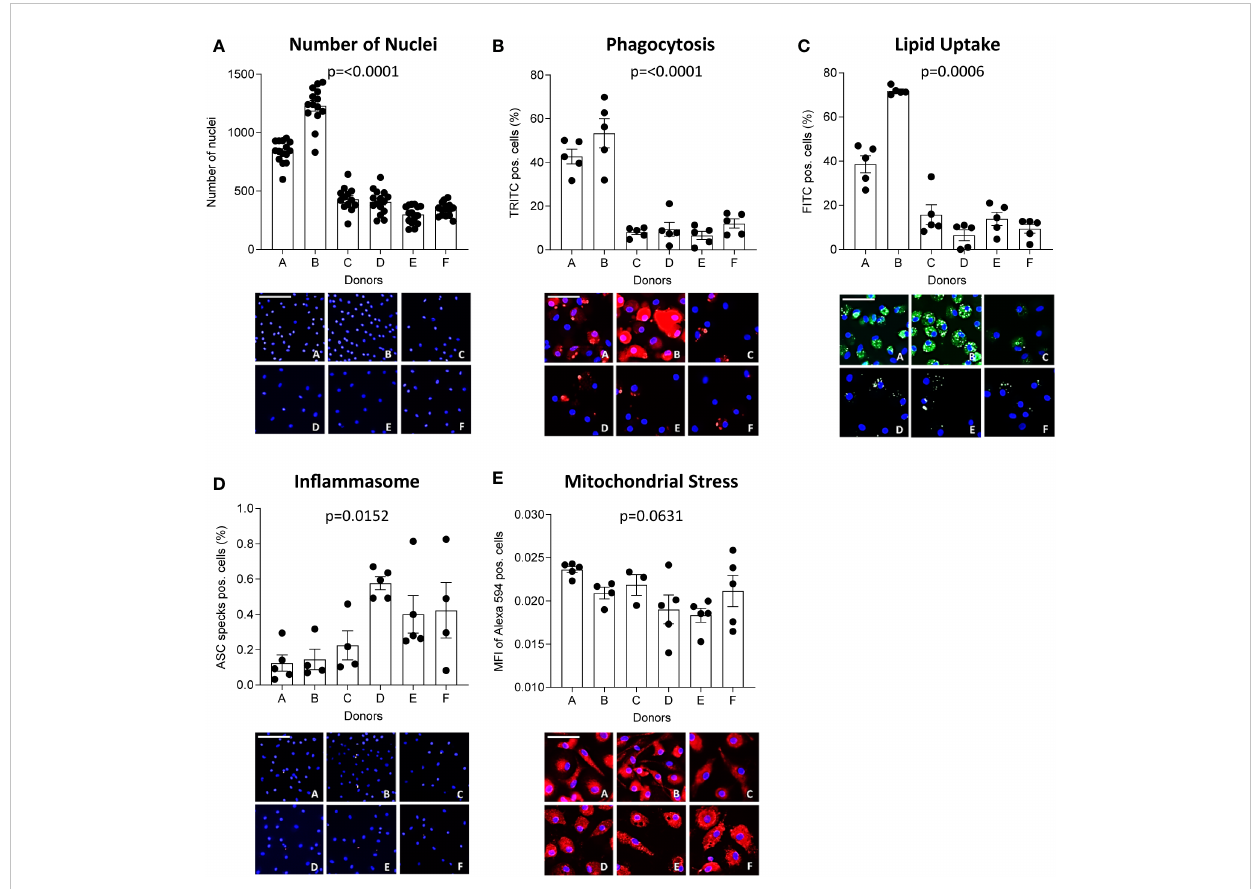
FIGURE 4 M F function differs between donors. CD14-positive monocytes of 6 healthy donors were seeded at 13,000 cells/well and differentiated into M F for 7 days using 100 ng/ml macrophage colony-stimulating factor (M-CSF). The number of nuclei per donor at experimentation (A) is given. Their functional phenotype was assessed using the MacroScreen platform: phagocytosis (B , red ) , lipid uptake (C , green ) , in fl ammasome activation (D , red ) , and mitochondrial stress (E , red ) . The scale bar corresponds to 25 m M. The indicated p-values refer to overall signi fi cance, multiple comparison signi fi cance can be found in Supplementary Table 3. MFI: Mean fl uorescence